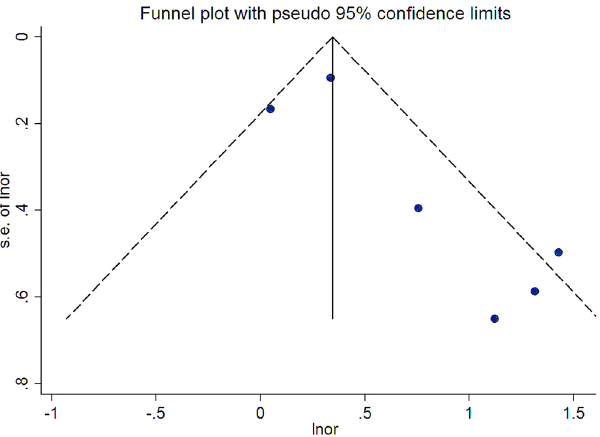
Figure 6. Funnel plot for publication bias test, each point represents a separate study for the indicated association. The horizontal and vertical axis correspond to the OR and confidence limits. s.e., standard